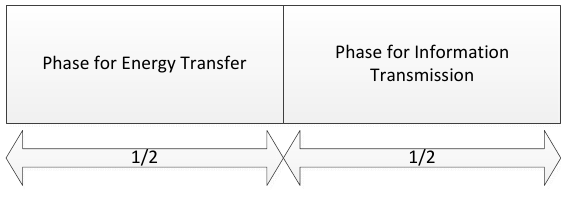
Figure 2. Time switching (TS) protocol.